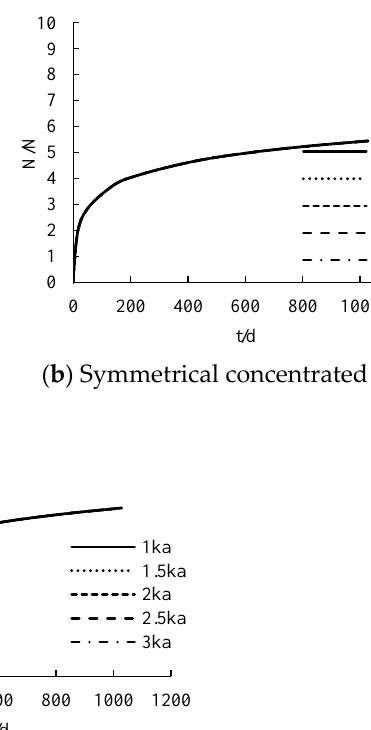
( c ) Mid-span concentrated load Figure 12. The influence of adhesive layer stiffness under creep on tensile force.